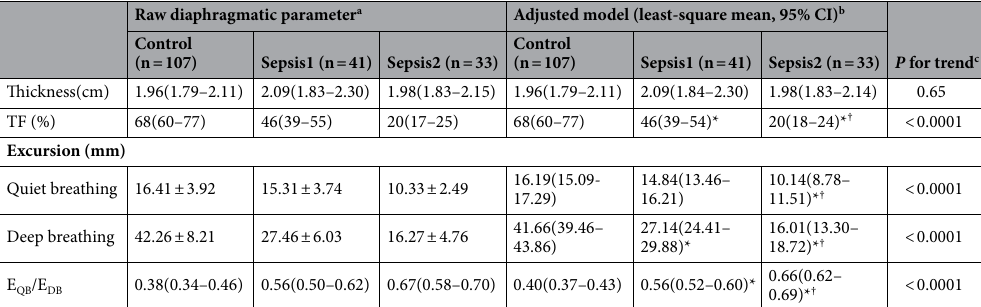
Diaphragm movement curve and function. Diaphragmatic excursion. The diaphragmatic excursion in sepsis group 2 [10.33 ± 2.49 mm] was lower than that in sepsis group 1 [15.31 ± 3.74 mm] and control group [16.41 ± 3.92 mm] during quiet breathing ( P < 0.05), but there was no significant difference between sepsis group 1 and control group. However, during deep breathing, the diaphragmatic excursion were both lower in sepsis group 1 [27.46 ± 6.03 mm] and sepsis group 2 [16.27 ± 4.76 mm] than that in control group [42.26 ± 8.21 mm] ( P < 0.05), and sepsis group 2 had a further downward trend than that in sepsis group 1( P for trend < 0.05) (Fig. 2C; Table 2). E QB /E DB . The E QB /E DB was both increased in sepsis group 1 [0.56(0.50–0.62)] and sepsis group 2 [0.67(0.58– 0.70)] than that in control group [0.38(0.34–0.46)] ( P < 0.05). Nevertheless, it was higher in sepsis group 2 than that in the sepsis group 1 ( P < 0.05) (Fig. 2B; Table 2).